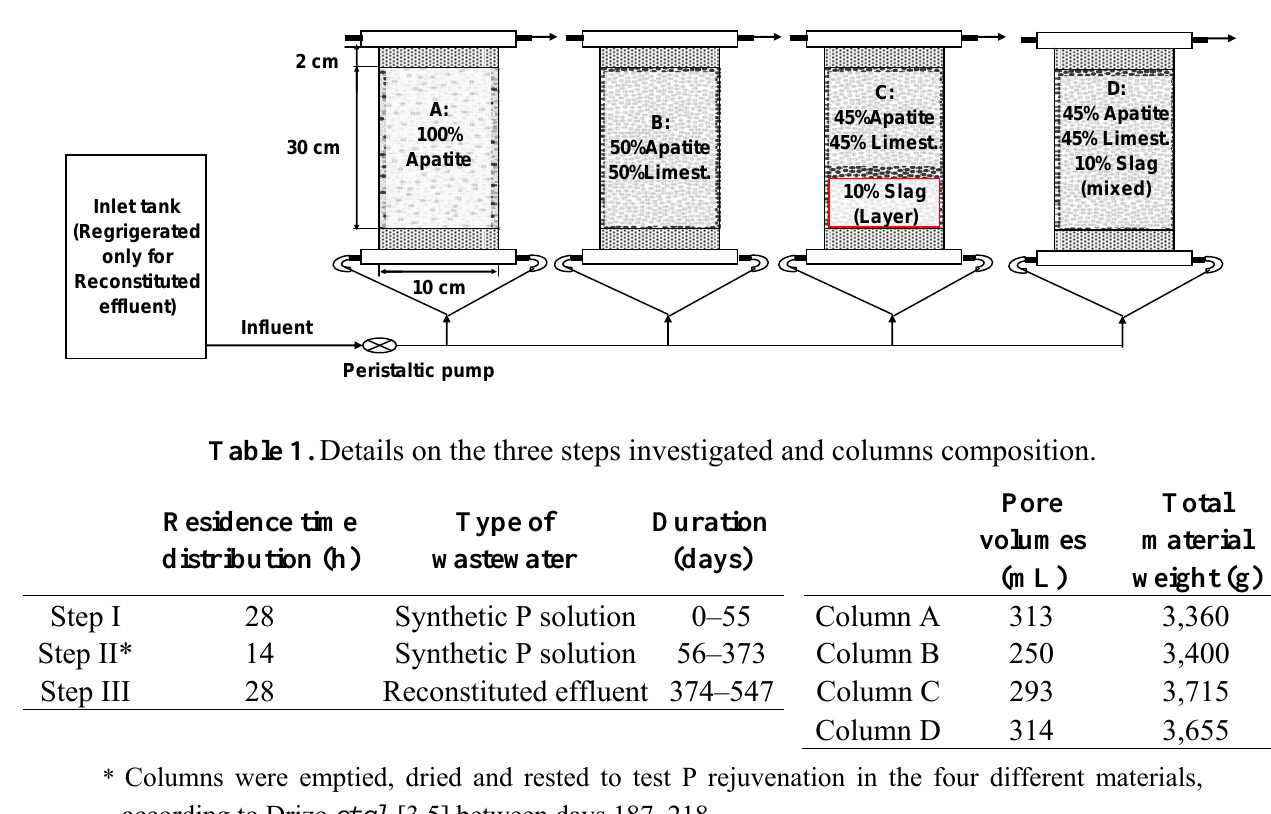
Figure 1. Experimental set up. Lab scale experiment (section view).